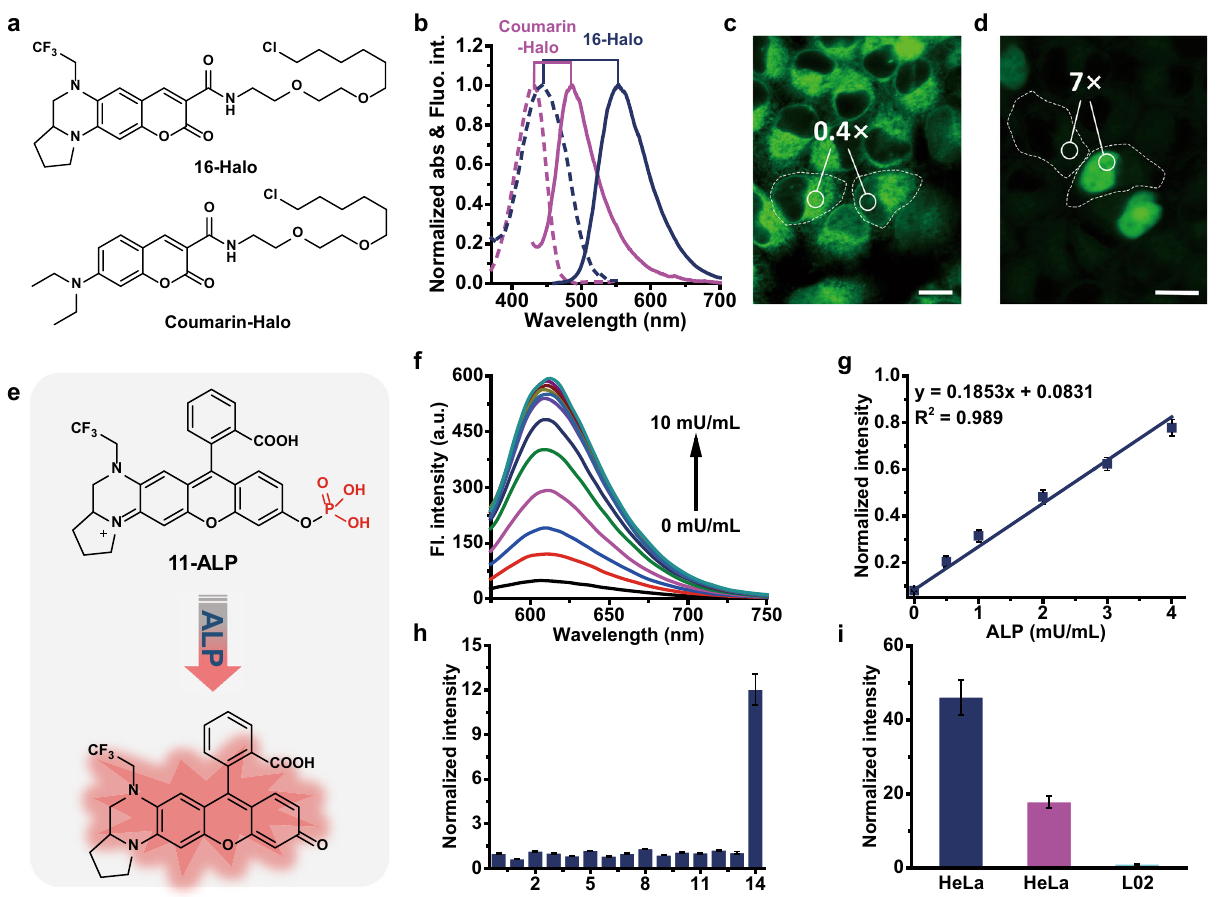
Fig. 5 Application of YL derivatives in bioimaging and biosensing. a Structures of 16-Halo and Coumarin-Halo. b Normalized absorption and emission spectra of 16-Halo and Coumarin-Halo. No-wash live-cell confocal images of co-cultured normal HeLa cells and HeLa cells expressing H2B-Halo labeled with 250 nM Coumarin-Halo ( c ) or 16-Halo ( d ). Scar bar, 20 μ m. e Structure of 11-ALP and its sensing mechanism. The moiety in red in 11-ALP indicates the response site of ALP. f The fl uorescence spectra of 11-ALP upon addition of ALP (0 – 10 mU/mL) in 10 mM tris-HCl buffer (pH 7.4). λ ex = 560 nm. g Linear fi tting curve of 11-ALP at 615 nm against ALP from 0 to 4 mU/mL. Error bars, ±s.e.m. n = 3. h Normalized fl uorescence responses of 11-ALP (5 μ M) to various biomolecules: (0) probe alone (5 μ M); (1) Na + (100 μ M); (2) K + (100 μ M); (3) Cysteine (100 μ M); (4) Homocysteine (100 μ M); (5) GSH (1 mM); (6) H 2 S (100 μ M); (7) H 2 O 2 (100 μ M); (8) ONOO − (5 μ M); (9) HClO (5 μ M); (10) Butyrylcholinesterase (BchE, 10 mU/mL); (11) Error bars, ±s.e.m. n = 3. i Evaluation of 11-ALP in sensing ALP of live L02 cells and HeLa cells. Live L02 cells and HeLa Cells were incubated with 11-ALP